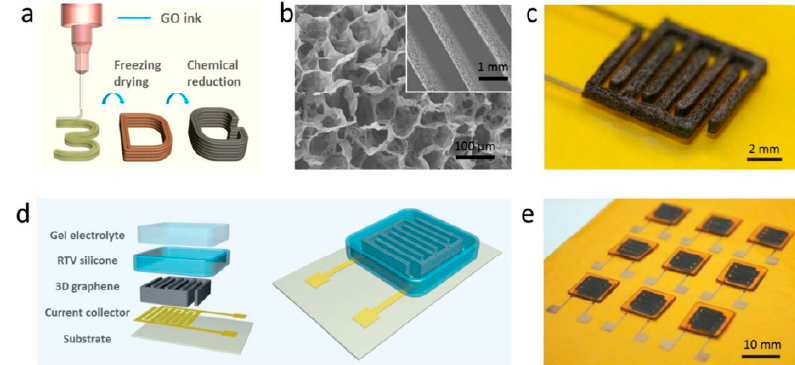
Figure 8. Schematic of printing a 3D micro supercapacitor. ( a ) 3D printing GO ink; ( b ) SEM image of 3D printed graphene electrode; ( c ) A 3D interdigitated structure of the electrode; ( d ) Assembling a 3D micro supercapacitor; ( e ) An array of the printed 3D micro supercapacitors. Reproduced from [60],